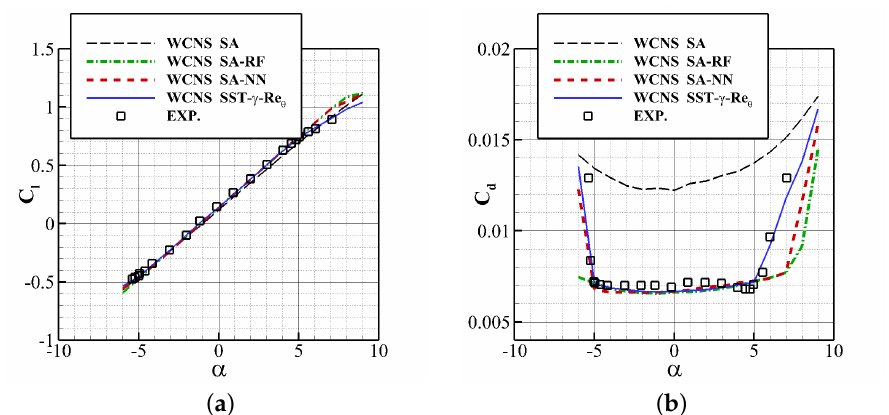
Figure 12. Lift coefficient and the drag coefficient predicted by data-driven transition models, SST- γ - Re θ and experiments. ( a ) Lift coefficient. ( b ) Drag